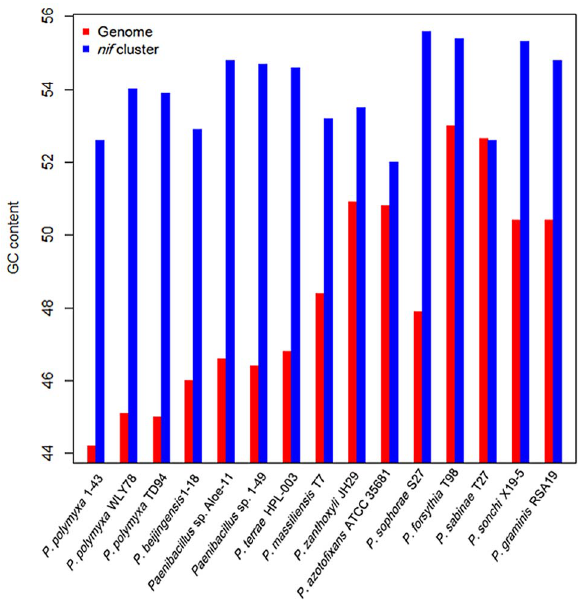
Figure 4. Comparison of G + C contents of the nif clusters with those of the average of the chromosomal